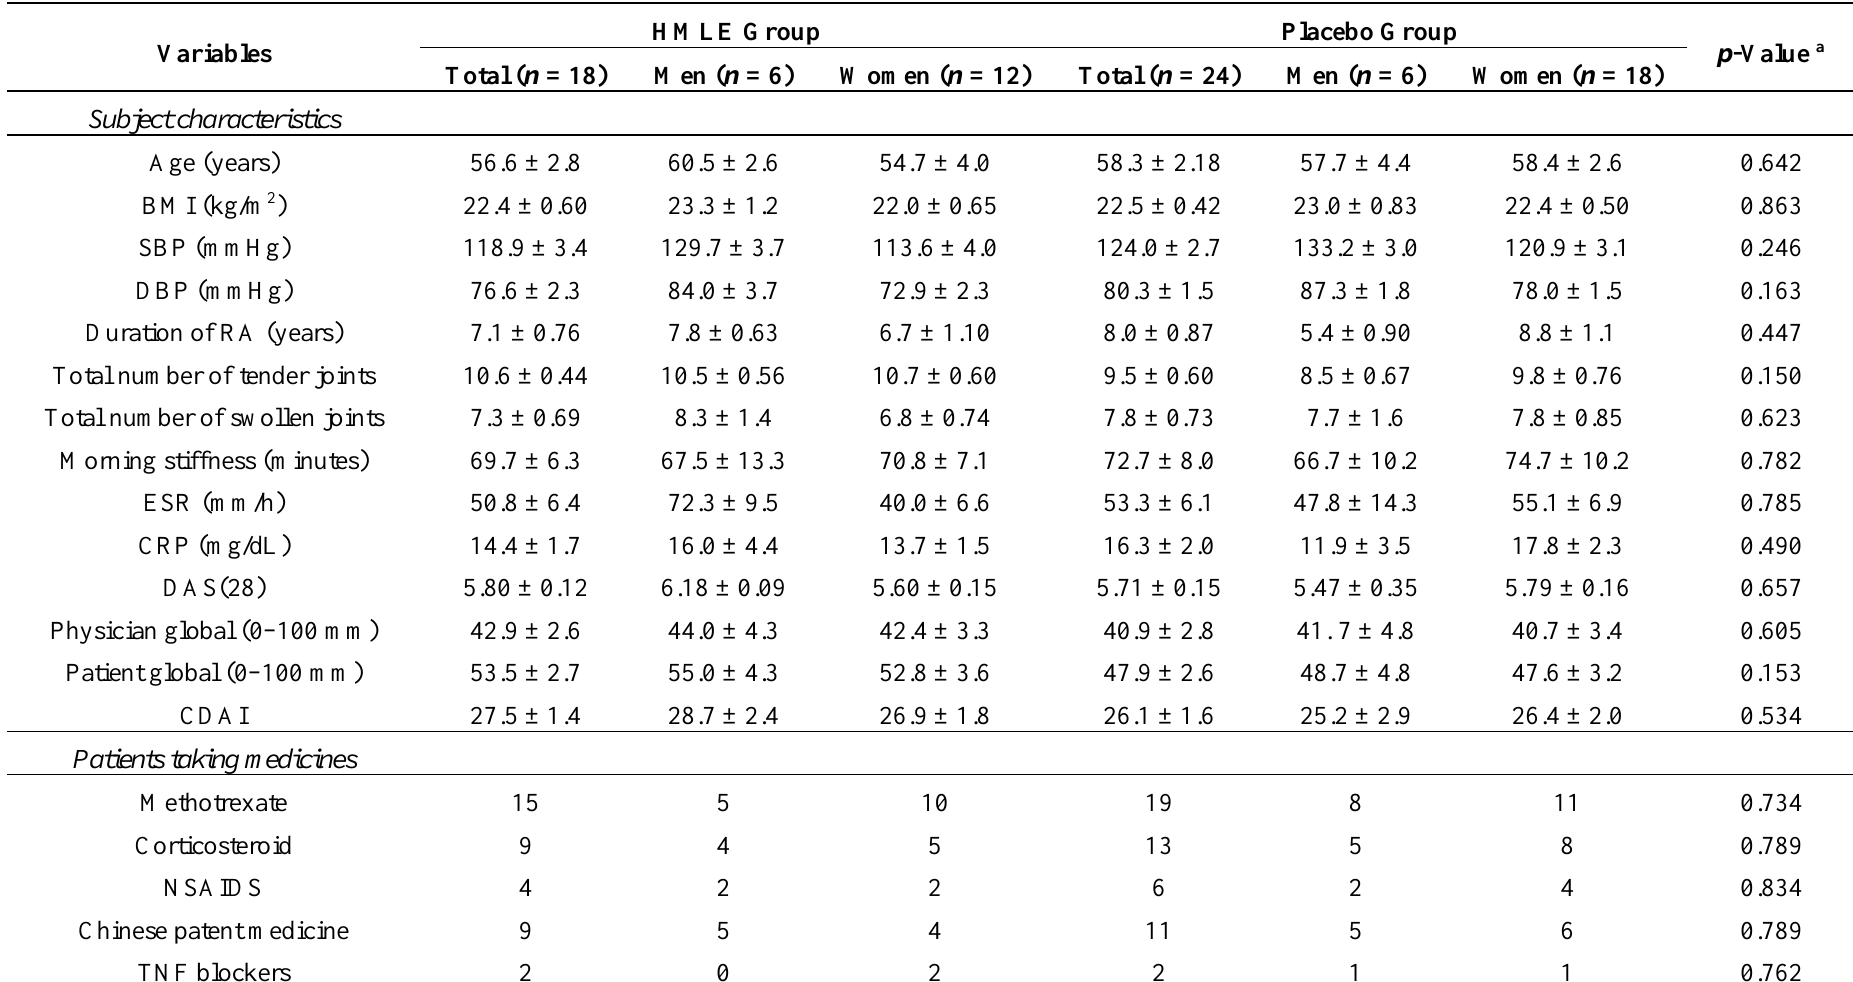
Table 2. Baseline characteristics of subjects completing the study who represents the per-protocol population